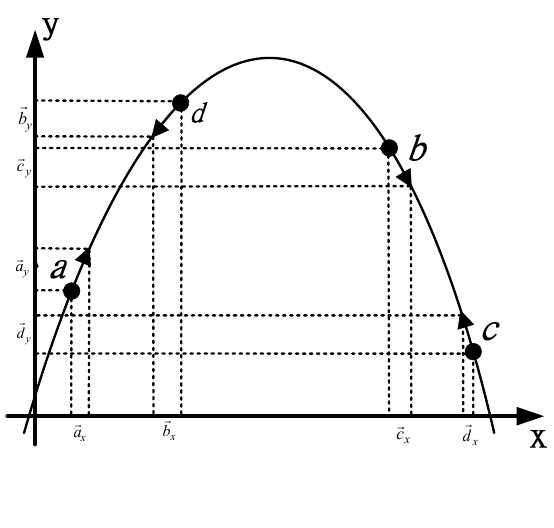
Figure 6. An illustration of ESC